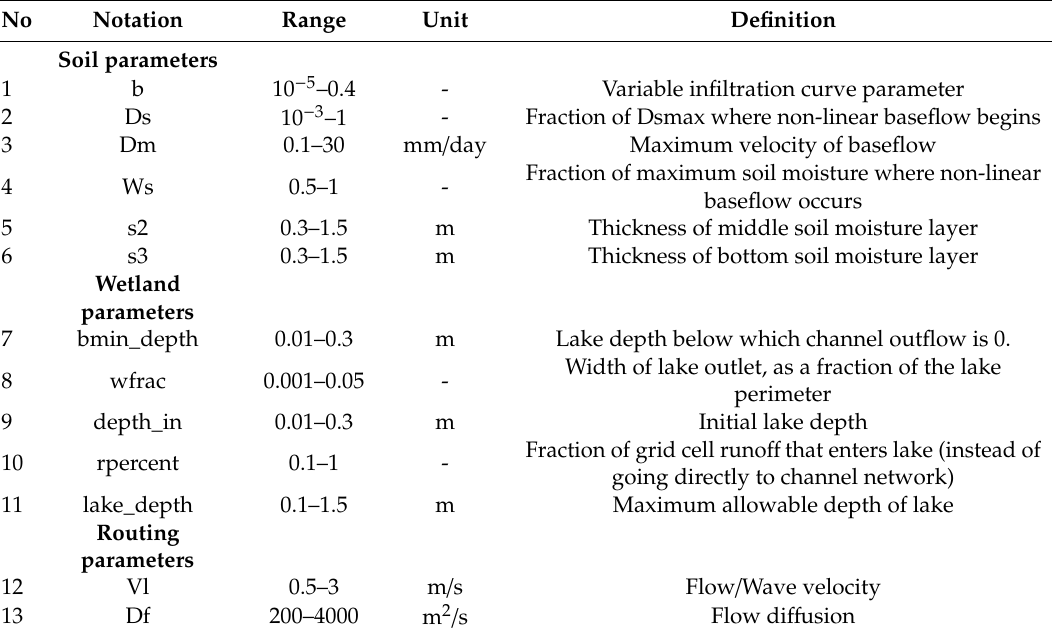
Figure A1. Soil and Land cover tiles discretization for VIC model. Table A4. VIC/RVIC model parameters.